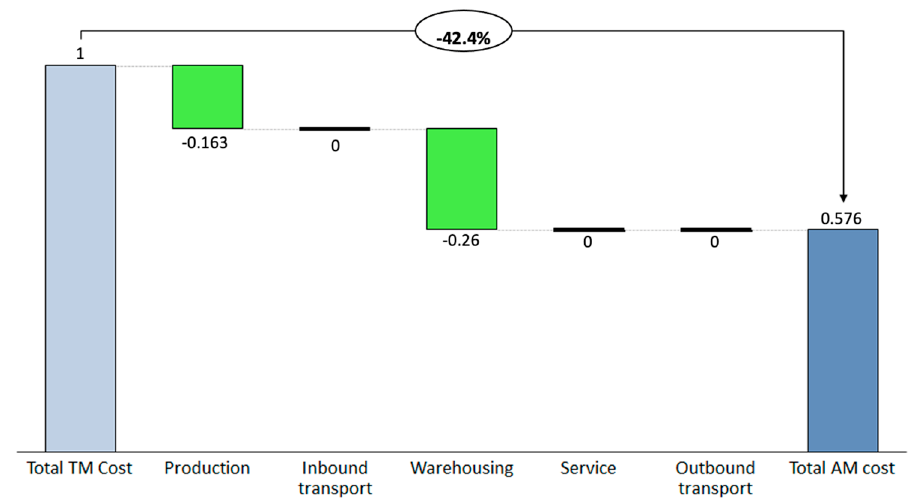
Figure 7. Difference in cost between AM and TM for P2, shown in normalized values.